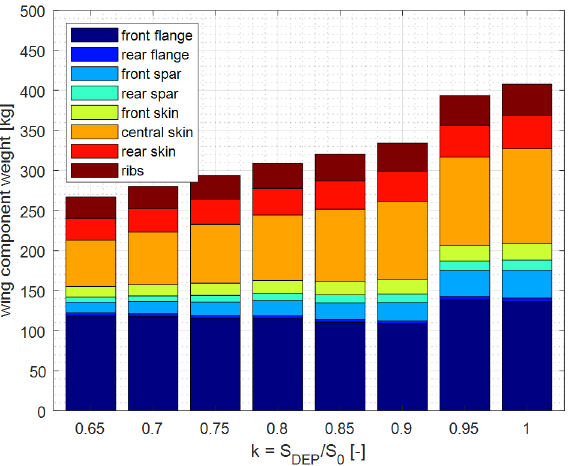
Figure 12. Weight distribution of wing components for different wing area ratios.